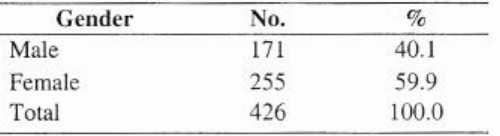
‘Table 1. Distribution of respondents by gender